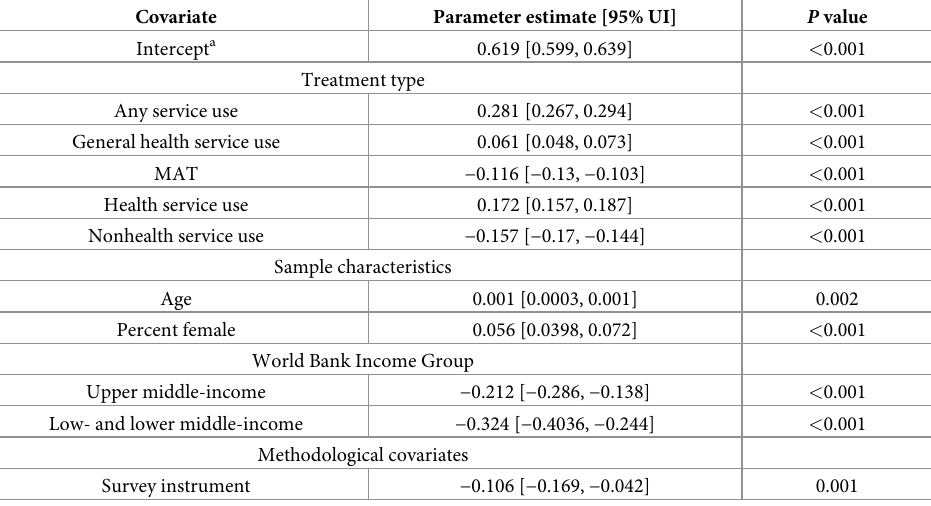
a Intercept represents mental health service use when all other variables are equal to their referent